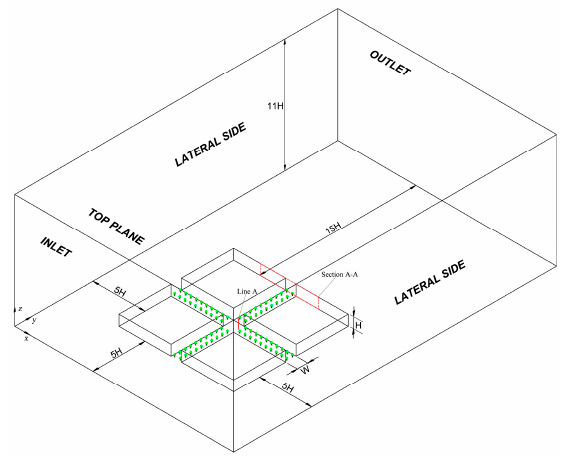
Figure 5. The computational domain.